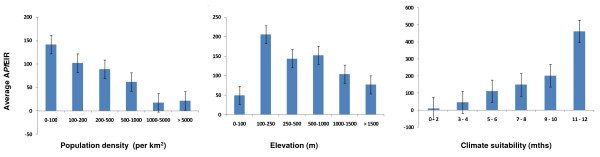
Average APfEIR estimates by population density, elevation and climate suitability groupings. Note. Numbers (n) for population density categories 0–100 (n = 130), 100–200 (n = 26), 200–500 (n = 38), 500–1000 (n = 12), 1000–5000 (n = 13), > 5000 (n = 11); for elevation categories 0–100 (n = 97), 100–250 (n = 38), 250–500 (n = 54), 500–1000 (n = 23) 1000–1500 (n = 13), > 1500 (n = 5) and; for climate suitability categories 0–2 (n = 16) 3–4 (n = 51), 5–6 (n = 89), 7–8 (n = 46), 9–10 (n = 25), 11–12 (n = 3).